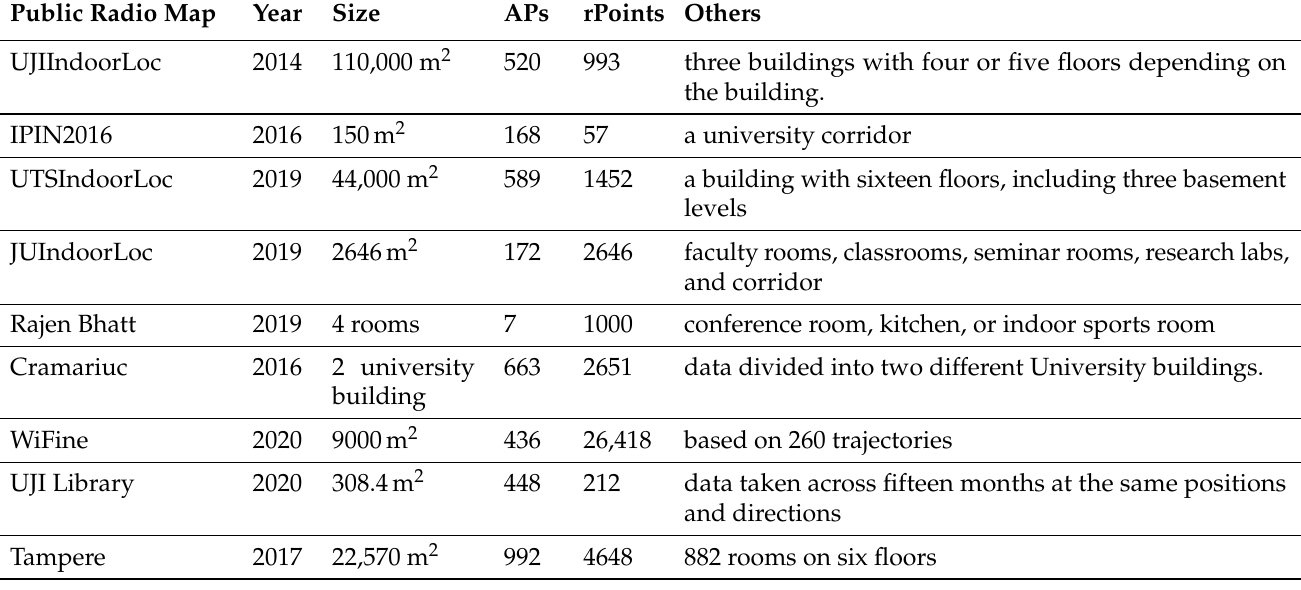
Table 1. Public dataset summary.